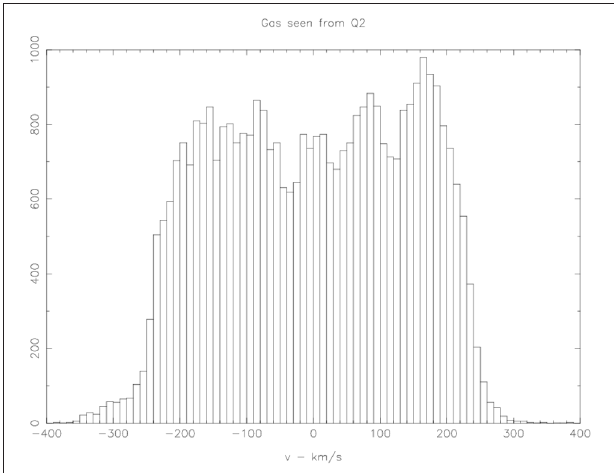
FIGURE 12 | Neutral hydrogen profile viewed from the orthogonal